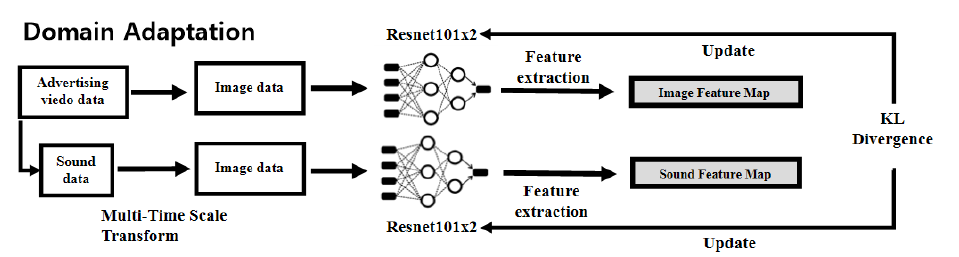
Figure 4. Domain adaptation phase with symmetric KL divergence based on mutual learning.